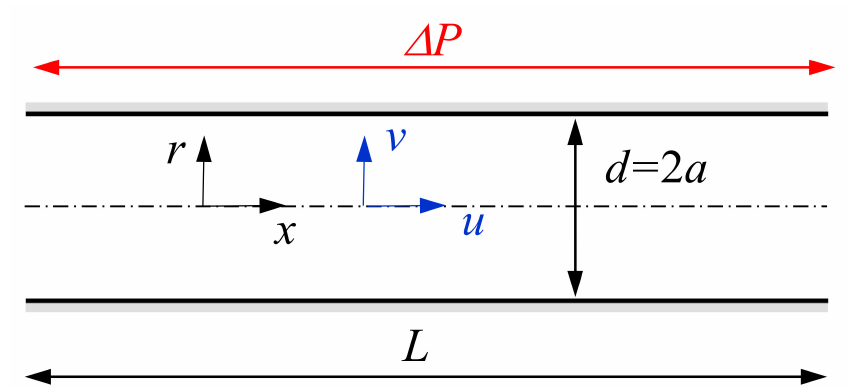
Figure 2. Schematic of the pipe-flow problem with coordinates and variables